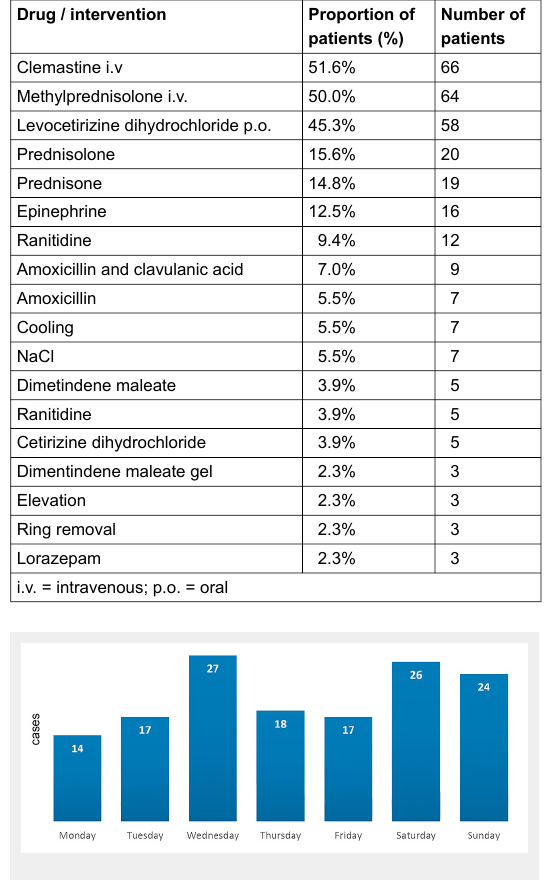
Table 2: Medication and interventions of patients. Drug /